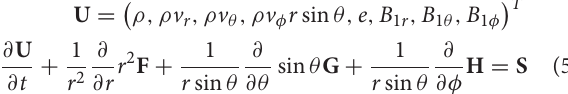
Frontiers in Astronomy and Space Sciences |